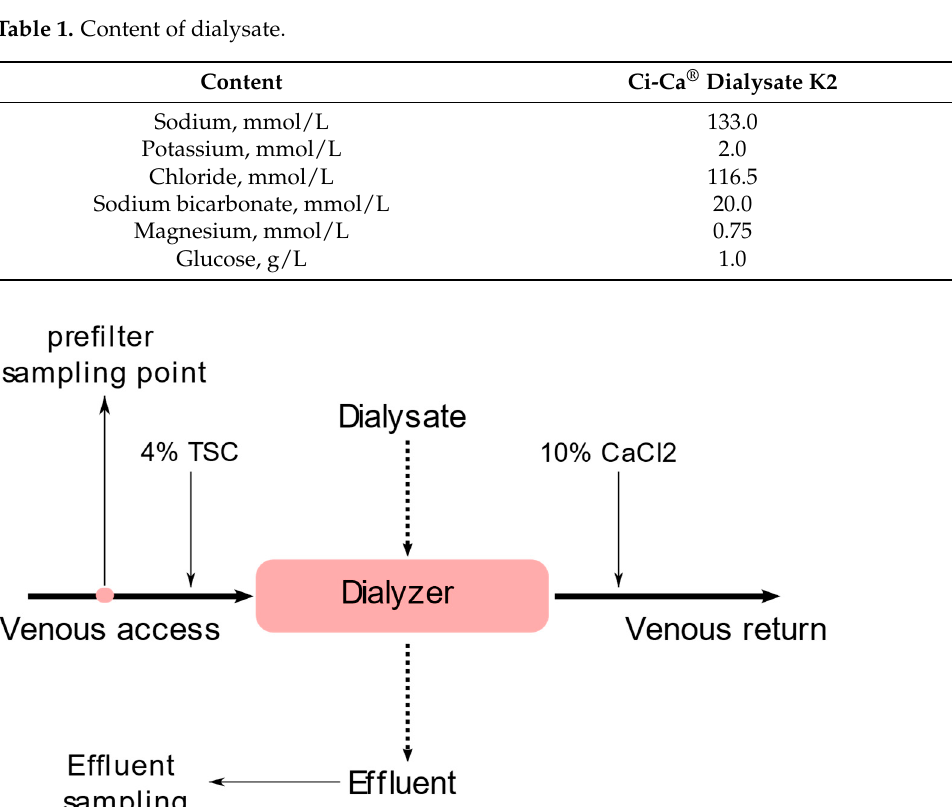
Figure 1. CVVHD set up and sampling